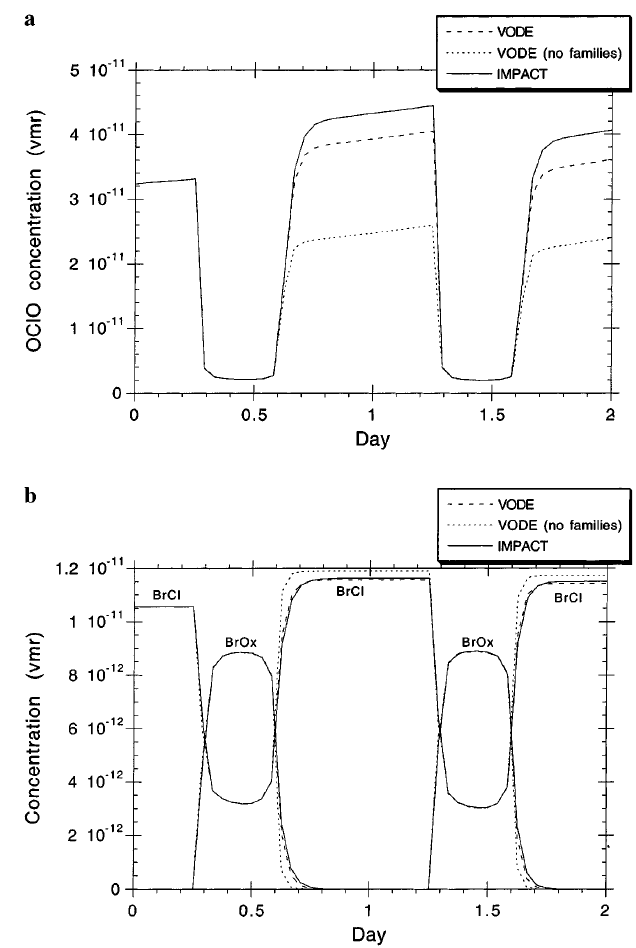
Fig. 2a,b. Comparison of results from a 6.5 day box model run using the IMPACT and VODE integrators for a OClO b BrO x and BrCl. Concentrations are in volume mixing ratio. Three curves are plotted for each species. The IMPACT integration is the solid curve . The long dashed curve is the VODE integration using chemical families, whereas the dotted curve is the VODE integration in which no chemical families or steady state species are used. Only the first two days of the run are shown for clarity